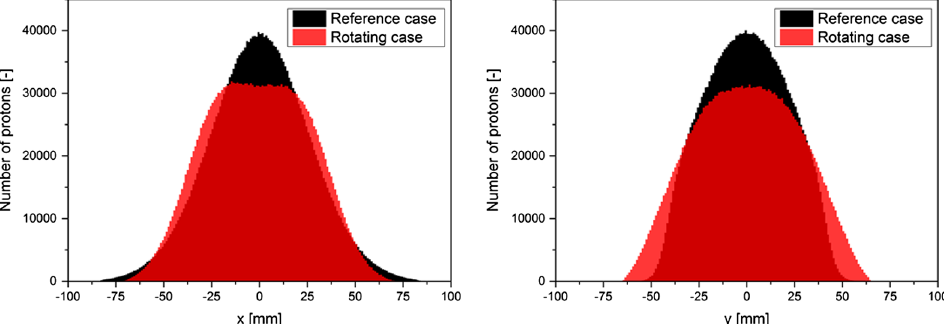
FIG. 6. 2 σ TURTLE simulation of the proton beam transverse distributions at the SINQ target entrance window in normal running conditions (top) and applying a beam rotation system (bottom). The coordinate system follows the TURTLE convention ( x is the bending plane).